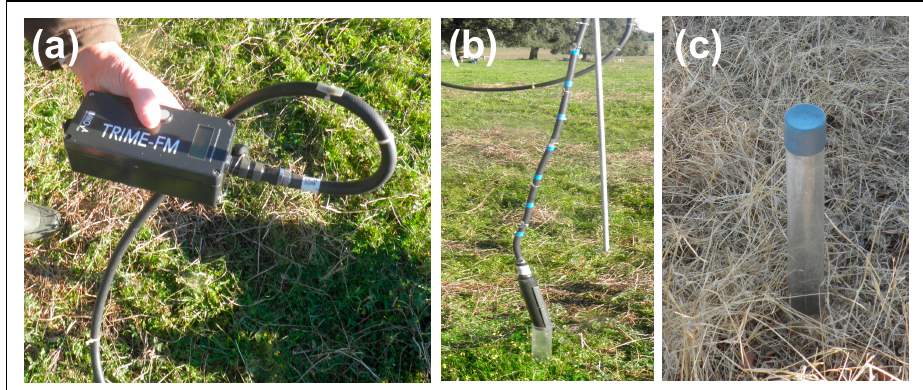
Figure 5. ( a ) TRIME-FM LC-display console; ( b ) TDR tube probe; ( c ) plastic tube installed in the ground.